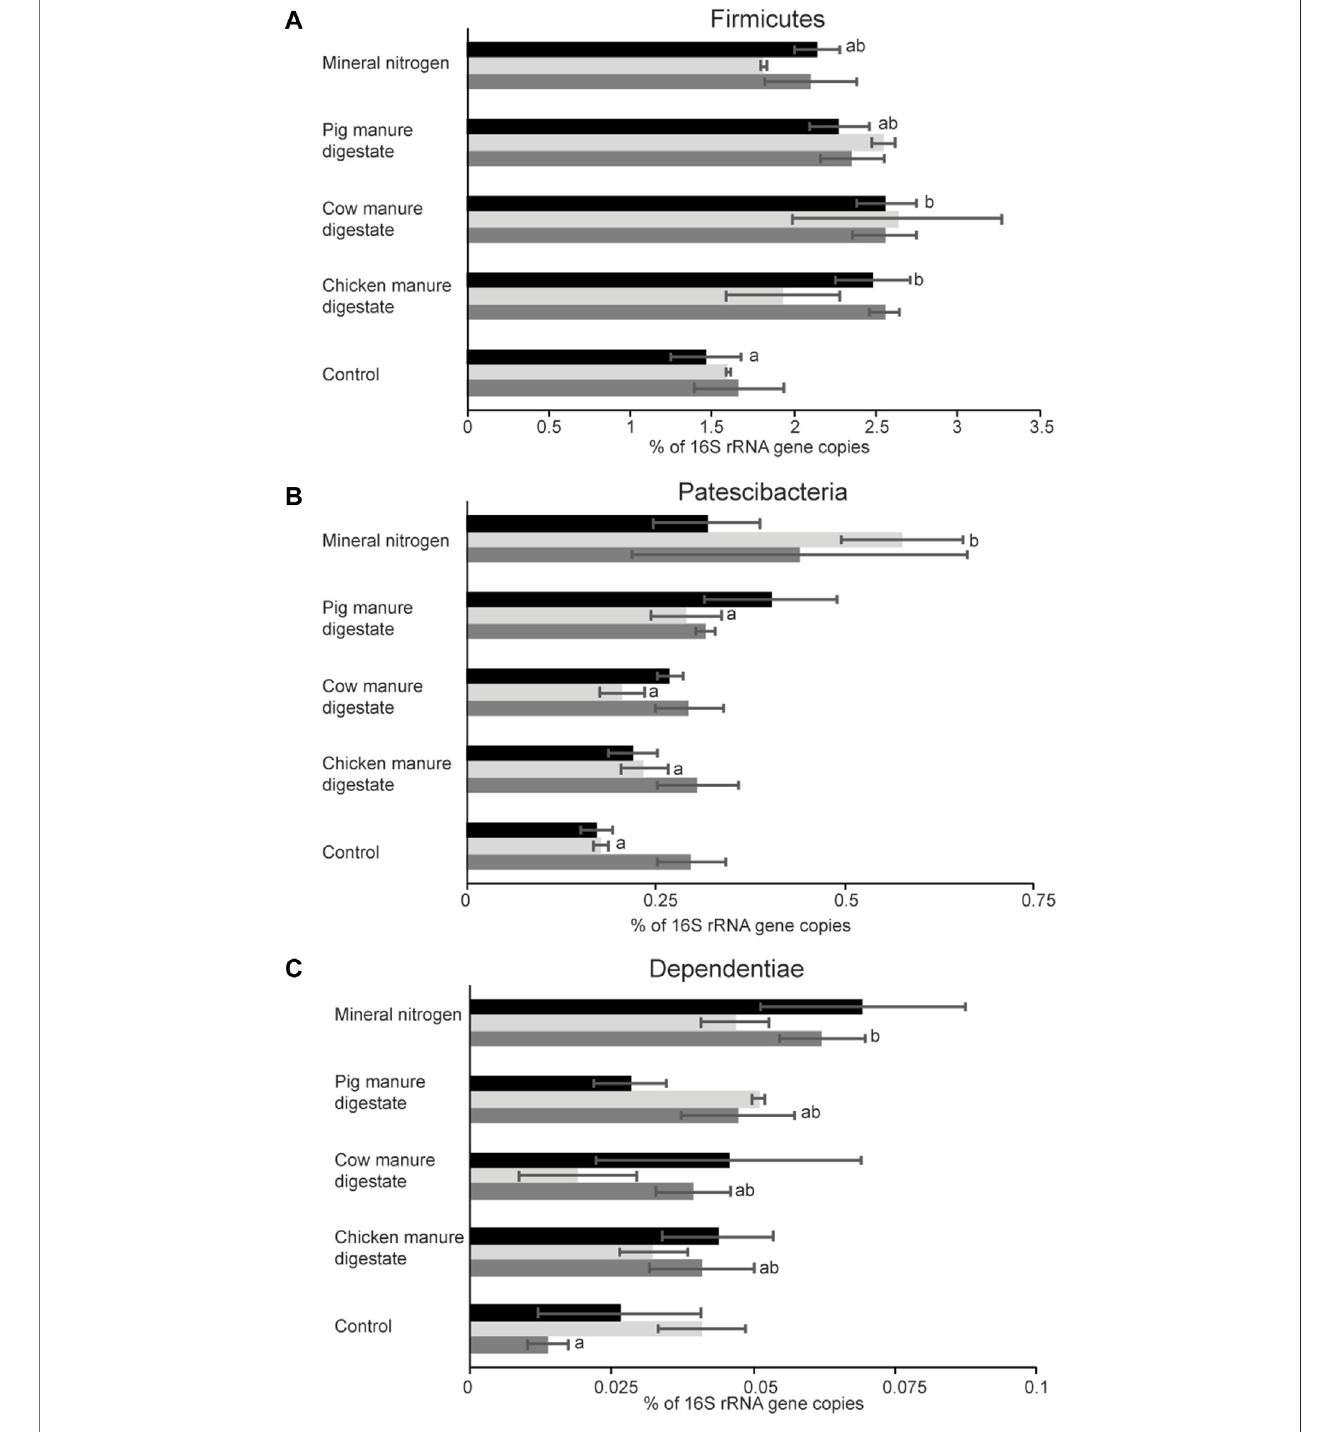
FIGURE 5 | Effect of the different fertilizers used at the phylum level after harvest. Each bar is labeled respective to the treatment applied and colored respective to the year of treatment: black (2018, fi rst year), light gray (2019, second year), and dark gray (2020, third year). (A) Firmicutes, (B) Patescibacteria, and (C) Dependentiae. Means sharing the same letter within the same year are not signi fi cantly different (post hoc Tukey ’ s HSD test or Dunn ’ s test).